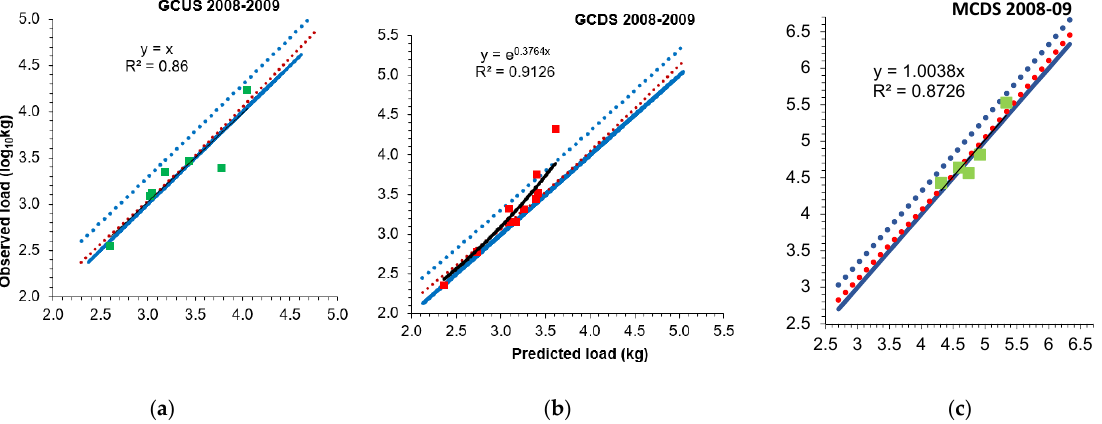
Figure 8. Relationship between OTL and PTL at GCUS ( a ), GCDS ( b ), and MCDS ( c ) (2008–2009). See Figure 7 for the explanation of the lines and colors of the points.